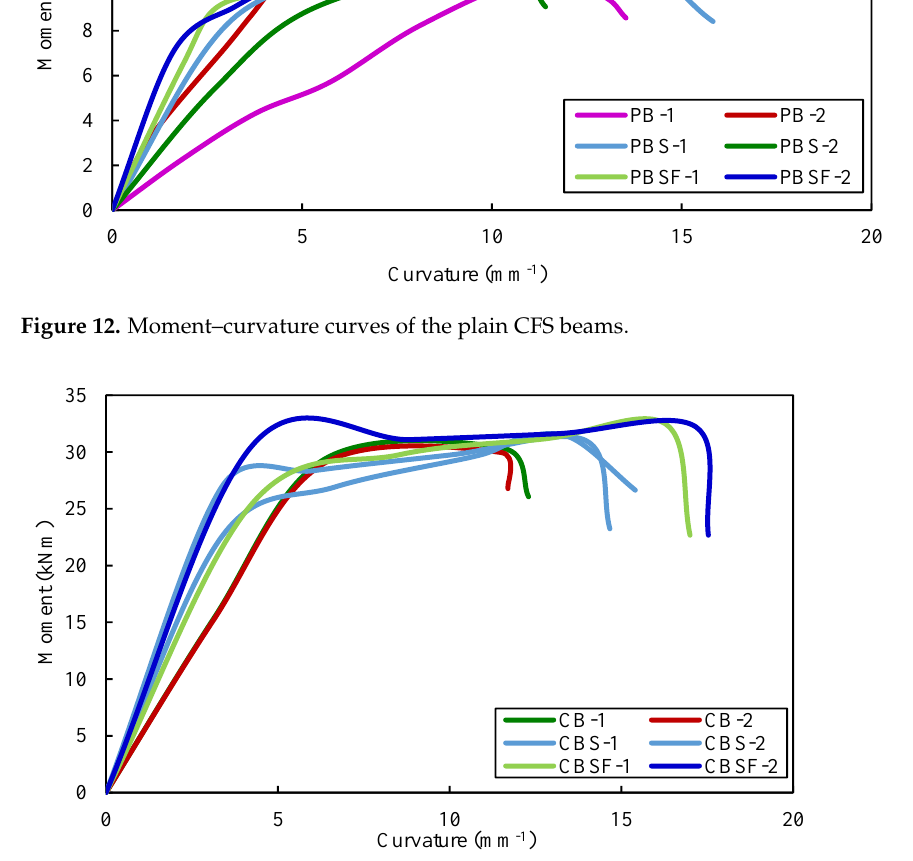
Figure 12. Moment – curvature curves of the plain CFS beams.